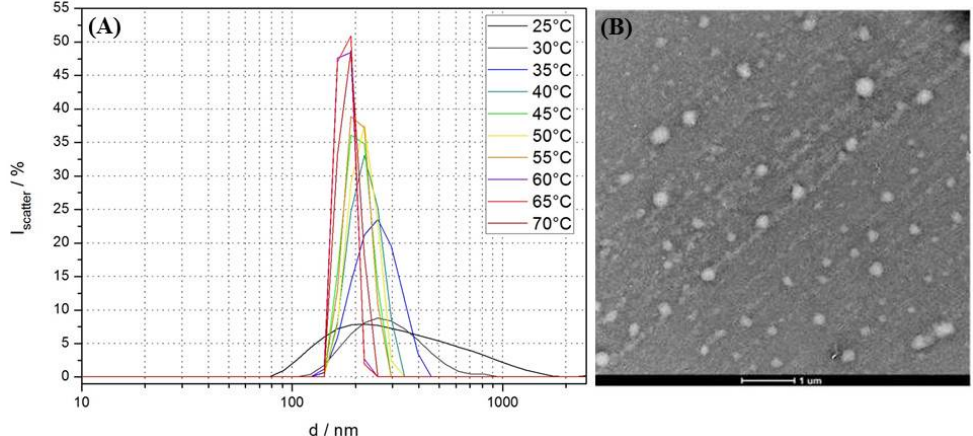
Figure 1. ( A ) Temperature ‐ dependent DLS size distributions at 25–70 °C in 5 °C steps of the crude PI ‐ b ‐ PNIPAM assemblies at 1 mg/mL prepared by THF solvent inversion into Milli ‐ Q